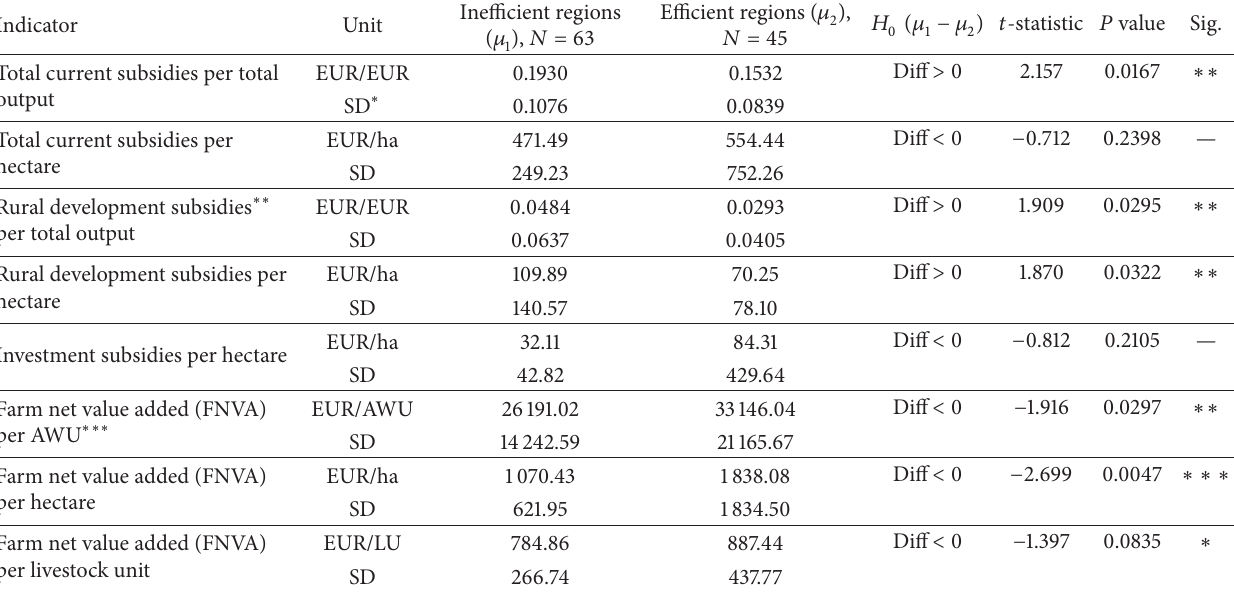
Table 7: Differences in income indicator FNVA/AWU and subsidies.